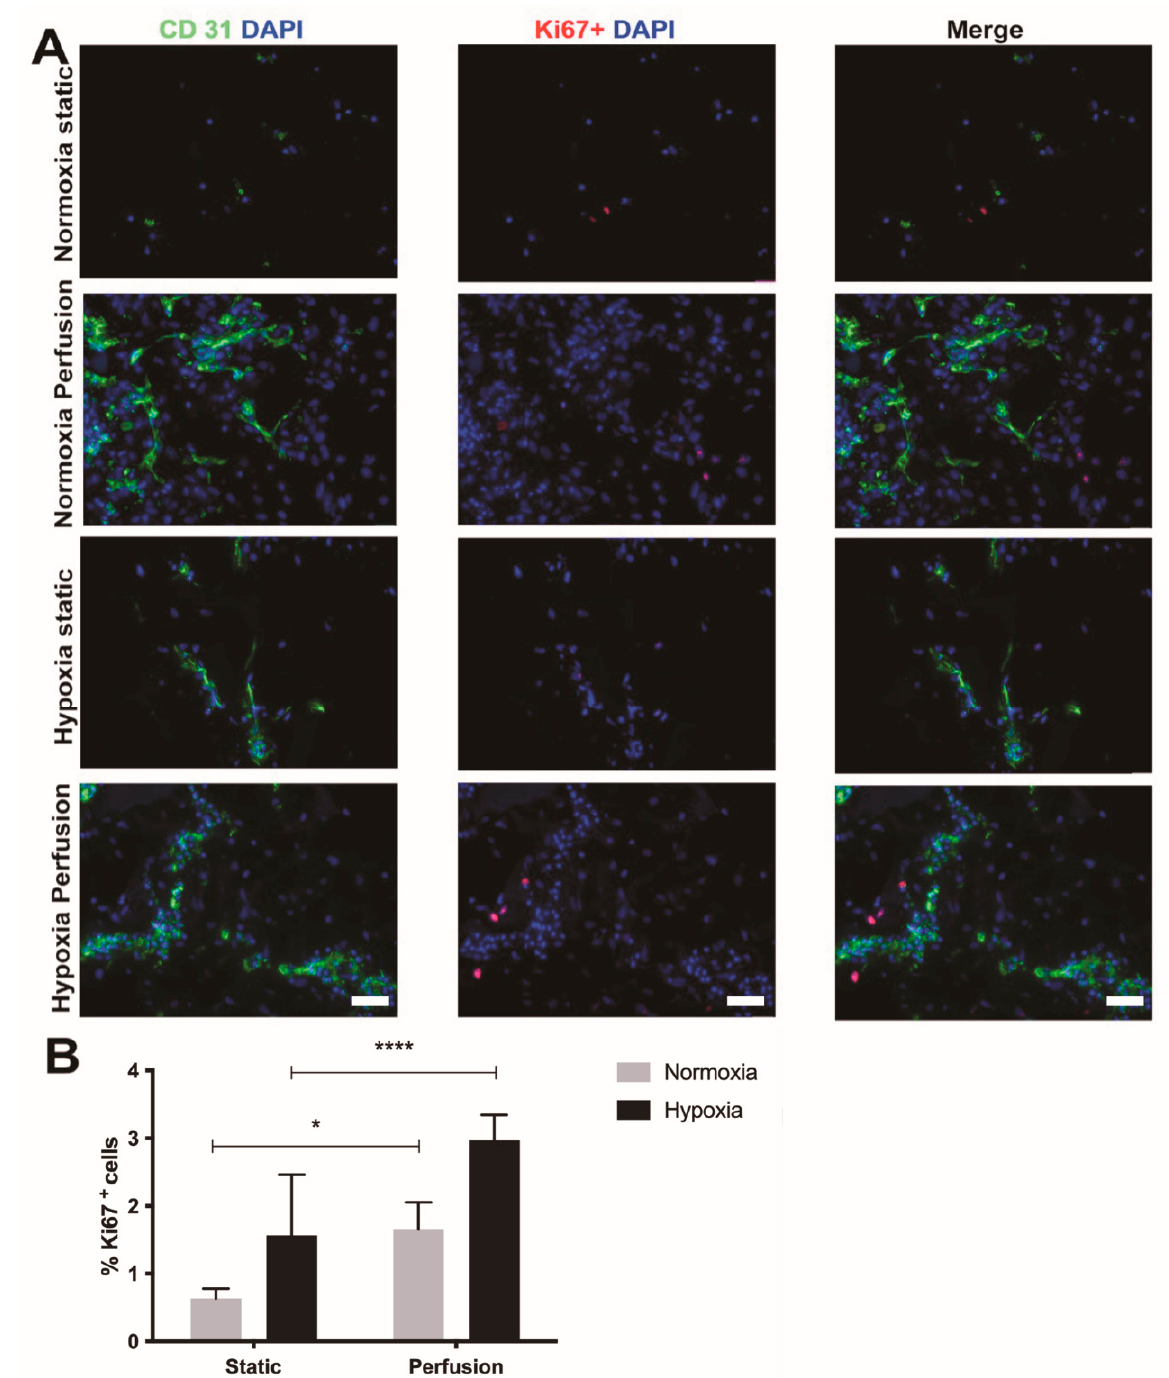
Figure 1. Stromal vascular fraction (SVF) cell-based constructs cultured in perfusion or static condition. ( A ) Immunostaining for endothelial cell marker PECAM-1 (CD31, green), proliferating cell marker Ki67 (red) of SVF cells cultured either in static or perfusion condition at either 21% or <1% O 2 . Cell nuclei were stained with DAPI (blue). Scale bar = 75 µ m. ( B ) Percentage of proliferating cells for static and perfusion conditions cultured under in vitro normoxia and hypoxia. n = 12 (1 donor). **** p < 0.0001. * p = 0.049.